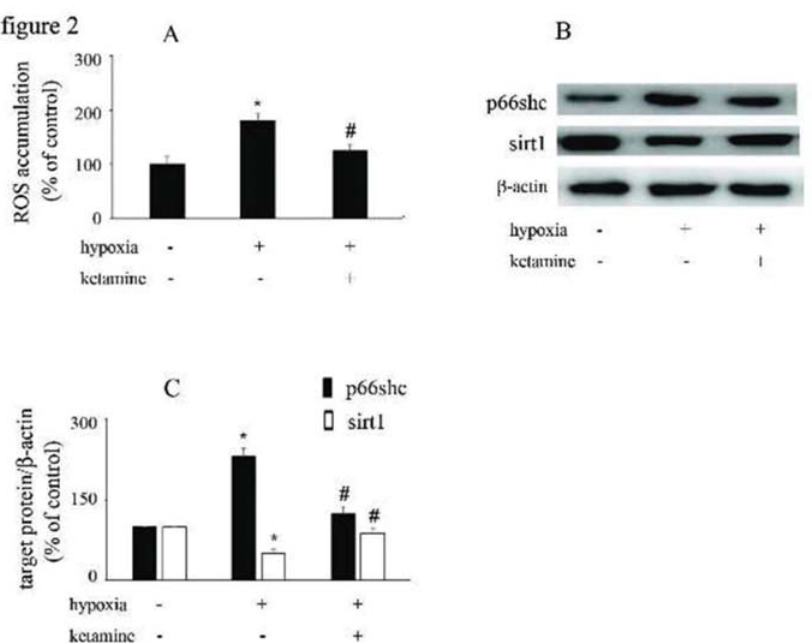
Figure 2 - The effects of ketamine on p66Shc and sirt1 expression in hypoxia-treated HUVECs. (A) Hypoxia induced ROS accumulation in HUVECs, which could be reversed by ketamine treatment. (B) Equal amounts of proteins were separated by SDS-PAGE and immunoblotted with antibodies against p66Shc and sirt1. (C) The ratio of the protein expression of each specific protein (p66Shc and sirt1) to the expression of b -actin (* p o 0.05 versus the control group, # p o 0.05 versus the hypoxia group, n=5).